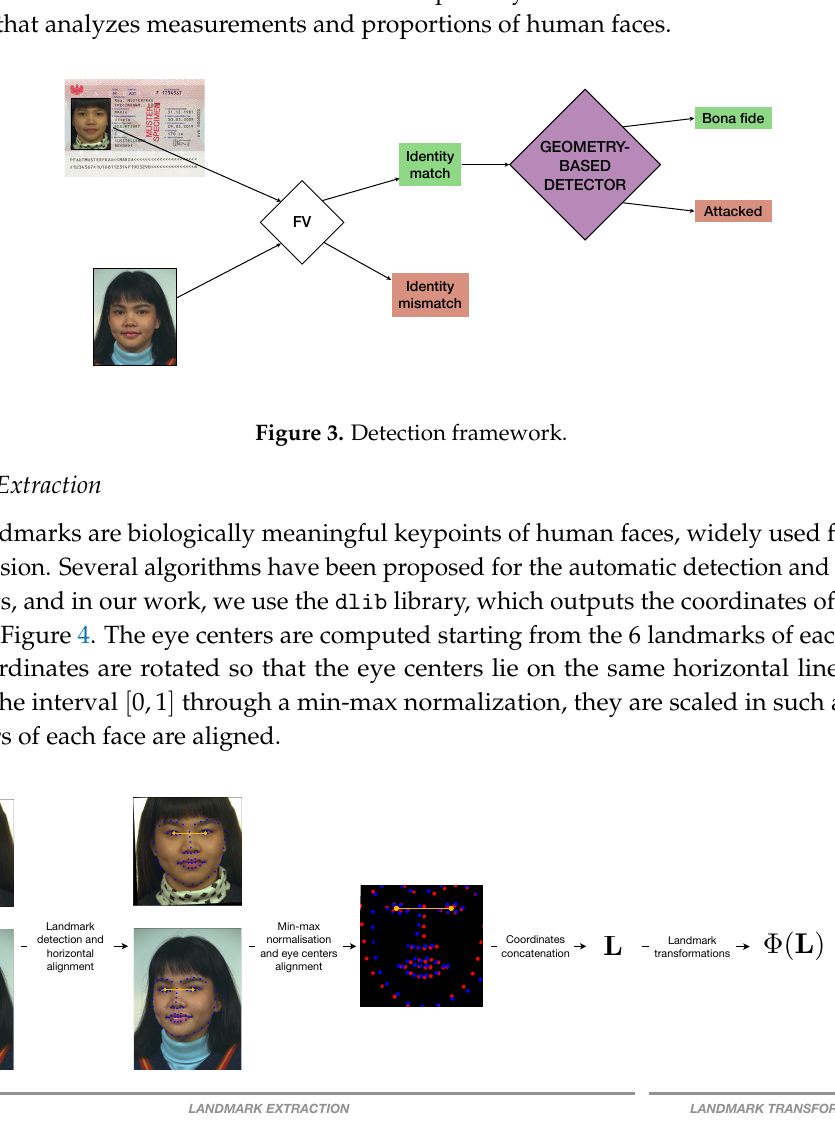
Figure 4. Landmark extraction and